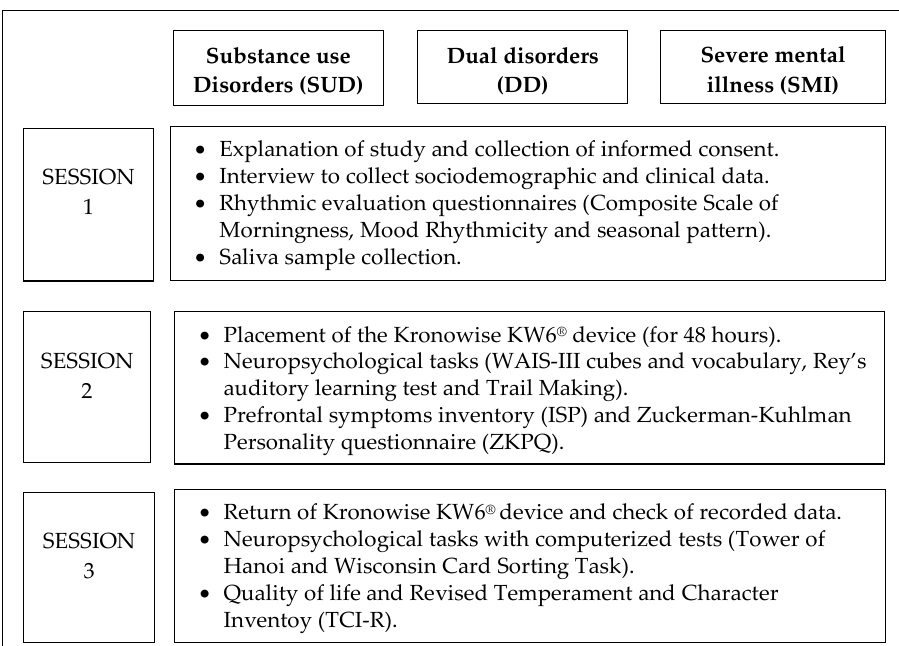
Figure 2. Breakdown of measurements for the sessions in study 1. Box 1. Instructions of habits and exposure to natural light stipulated for patients assigned to